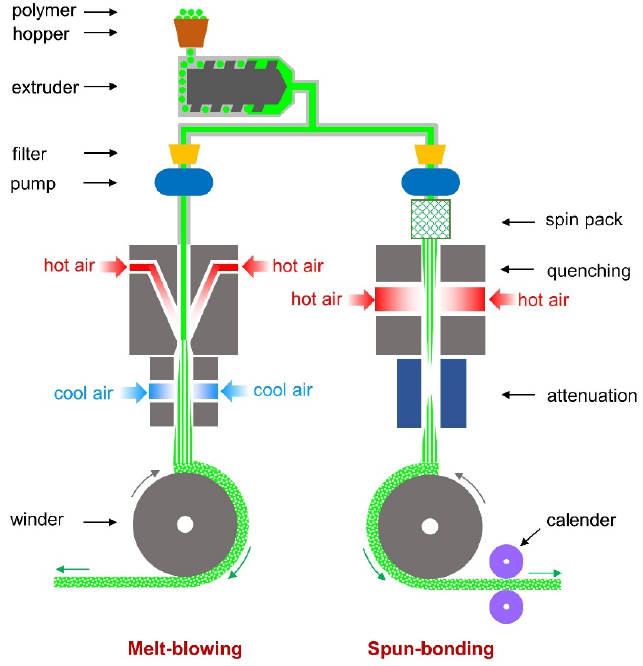
Figure 2. Comparison of two applied techniques of PLA nonwoven fabrics production.